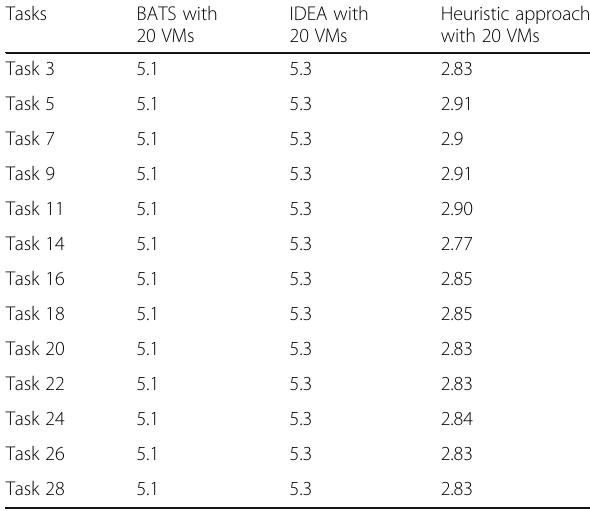
Table 17 Comparison of proposed heuristic approach with the BATS and IDEA frameworks in terms of RT in ms